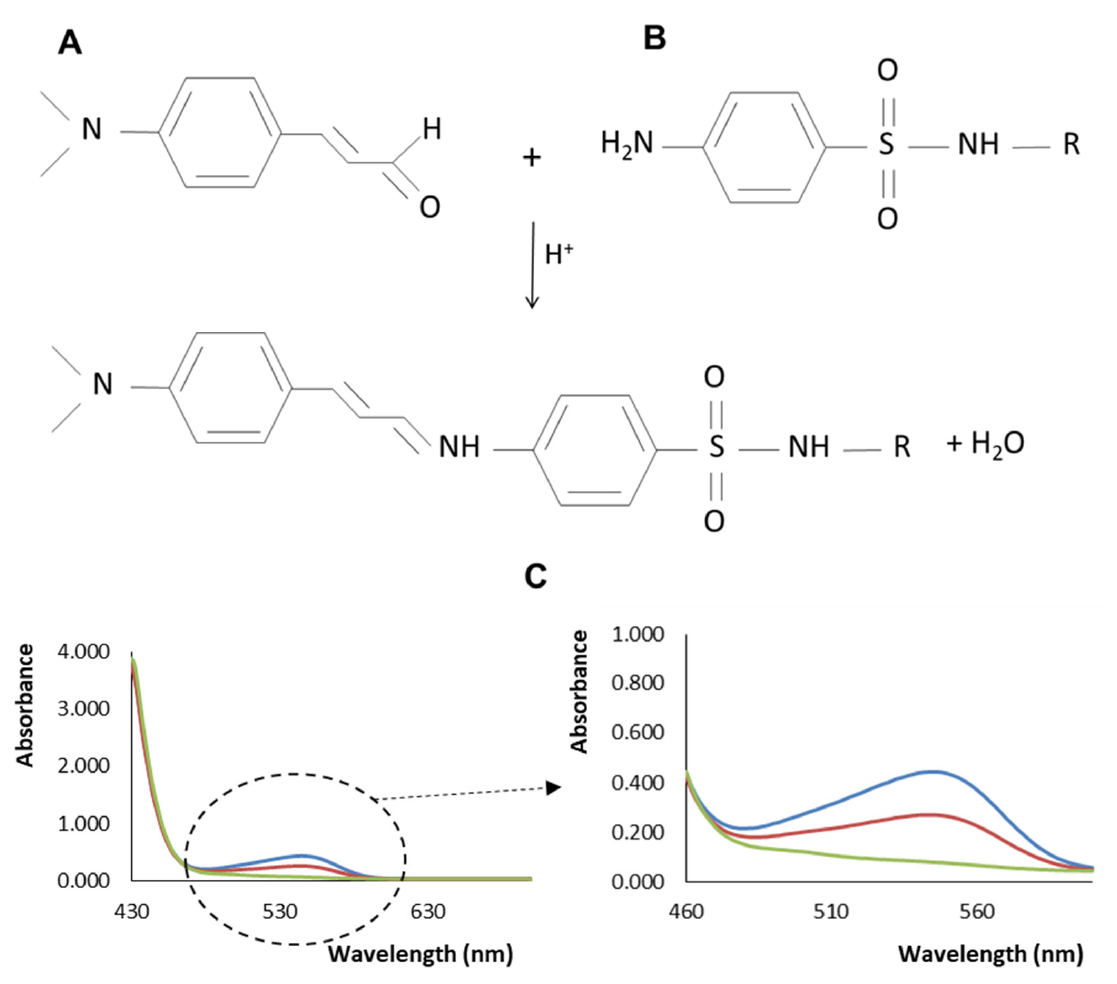
Figure 2. Scheme of colorimetric reaction between DMACA and sulfonamides in acid medium: ( A ). DMACA; ( B ). Sulfonamide; ( C ). Colored Schiff base product. Followed by the absorbance spectrum between 430 and 700 nm. Green line: no SMZ; red line: 10 µM SMZ; blue line: 20 µM SMZ.